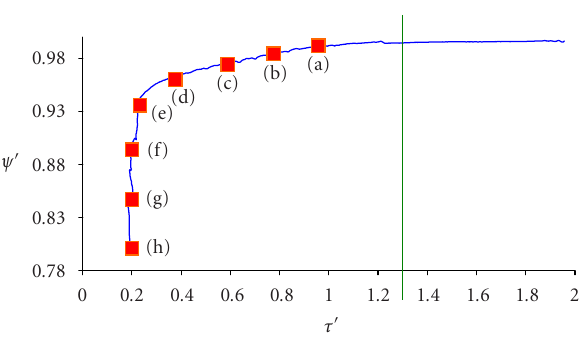
Figure 7: Head drop chart at nominal flow rate. The red squares indicate the cavitating conditions visualized on Figure 8. The green line corresponds to the apparition of